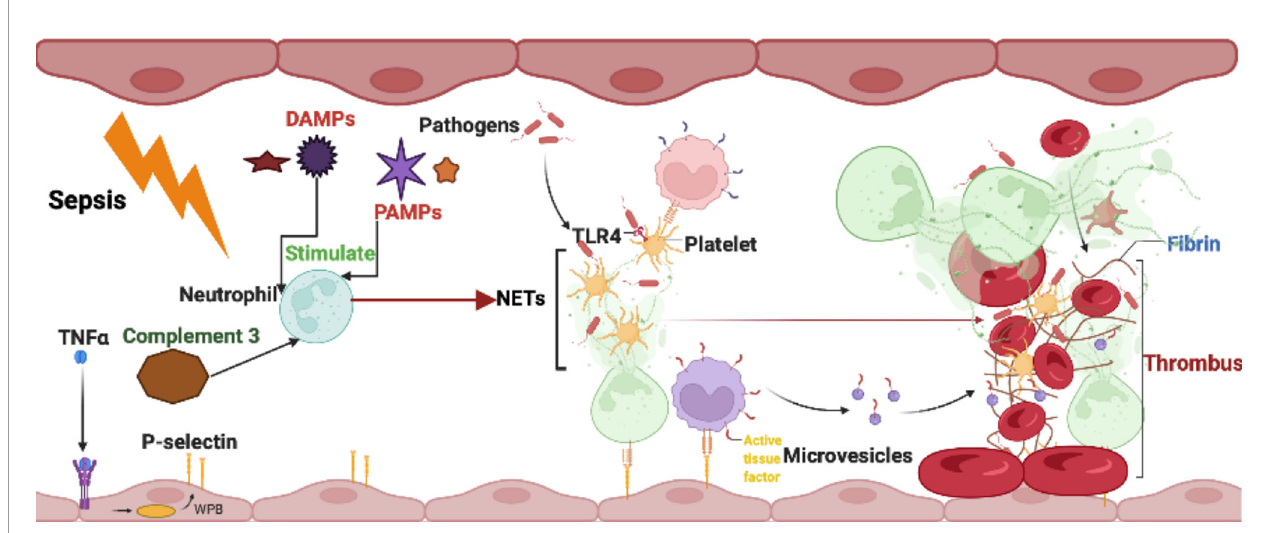
FIGURE 2 | Interaction between NETs and other blood cells in thrombosis